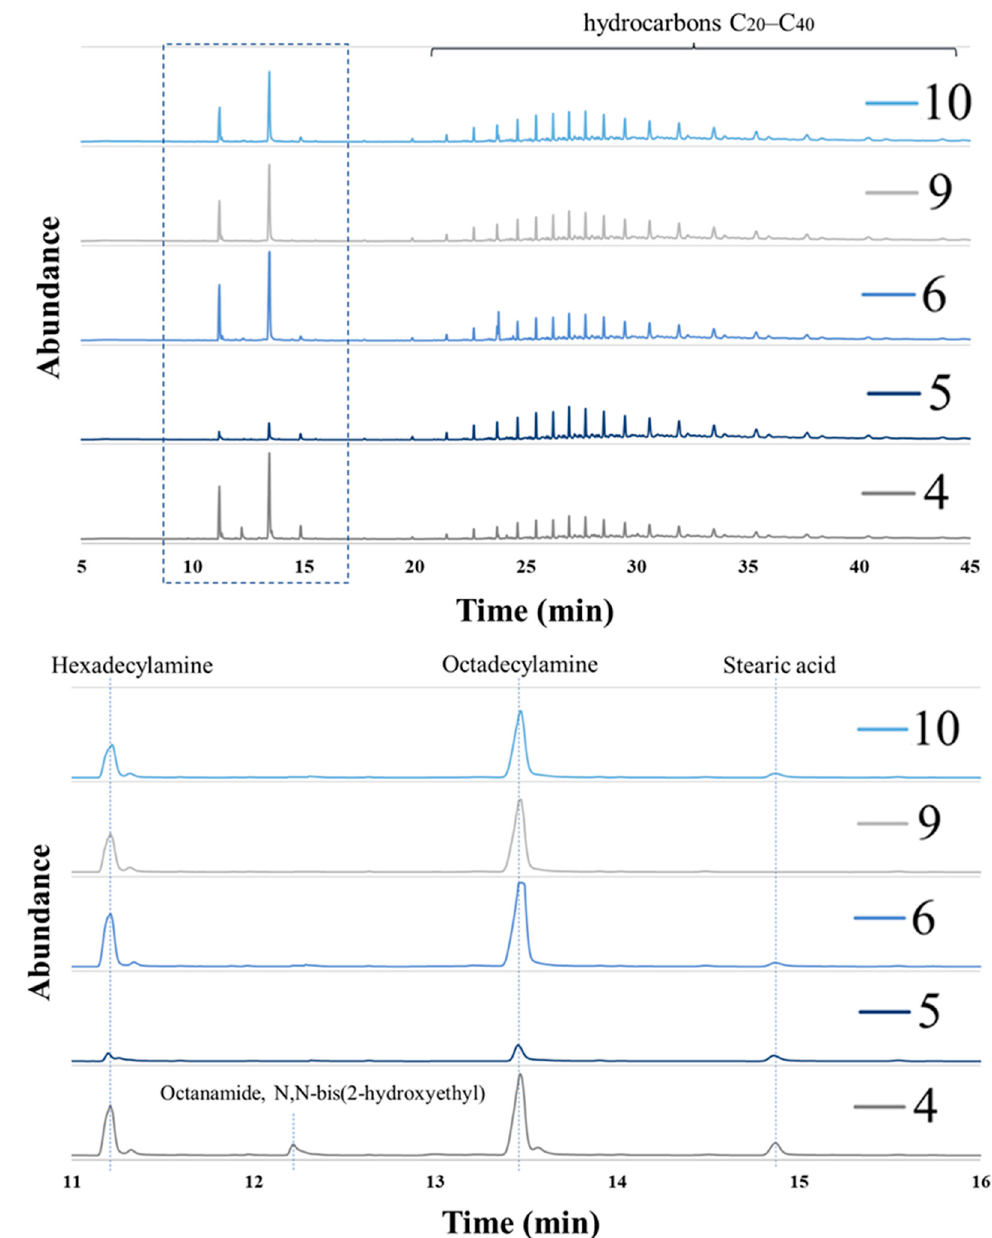
Figure 6. Chromatograms of the prepared